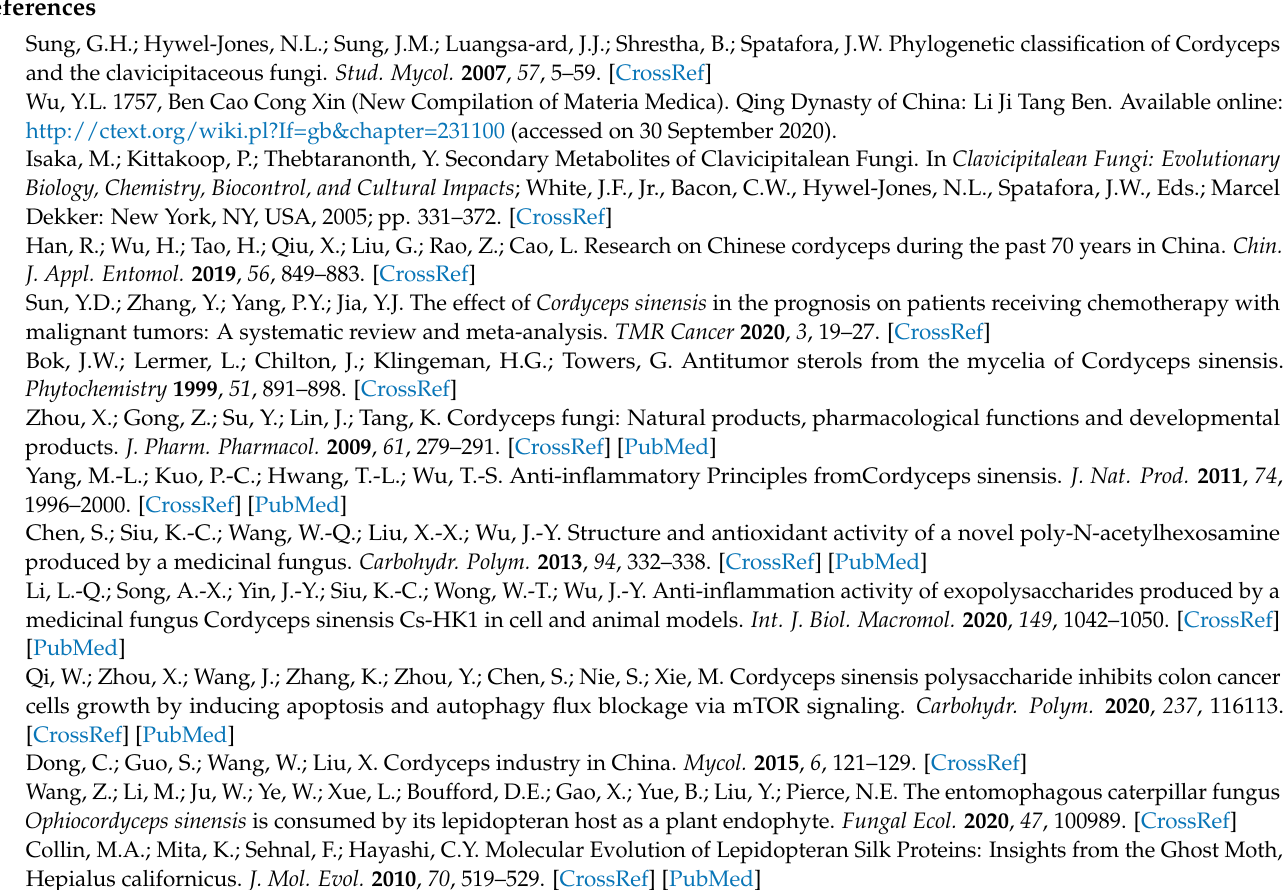
Table S3, Abundance profiles of identified metabolites; Table S4, Sample-based top ten concentrated metabolites; Table S5, SAM results; Table S6, Pathway predictions of featured